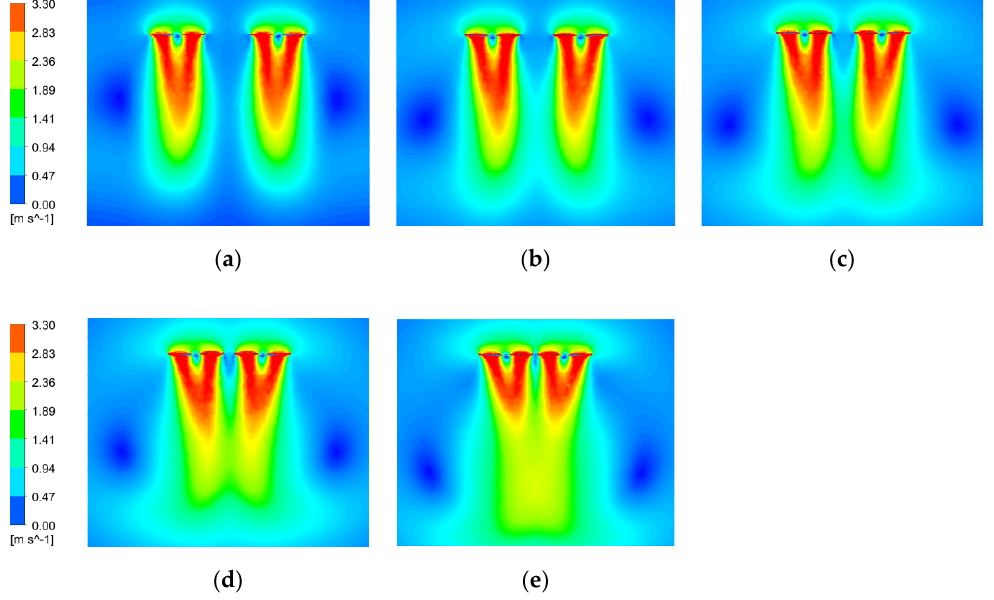
Figure 9. Velocity distribution. ( a ) L / D = 1.8; ( b ) L / D = 1.6; ( c ) L / D = 1.4; ( d ) L / D = 1.2; ( e ) L / D = 1.0.